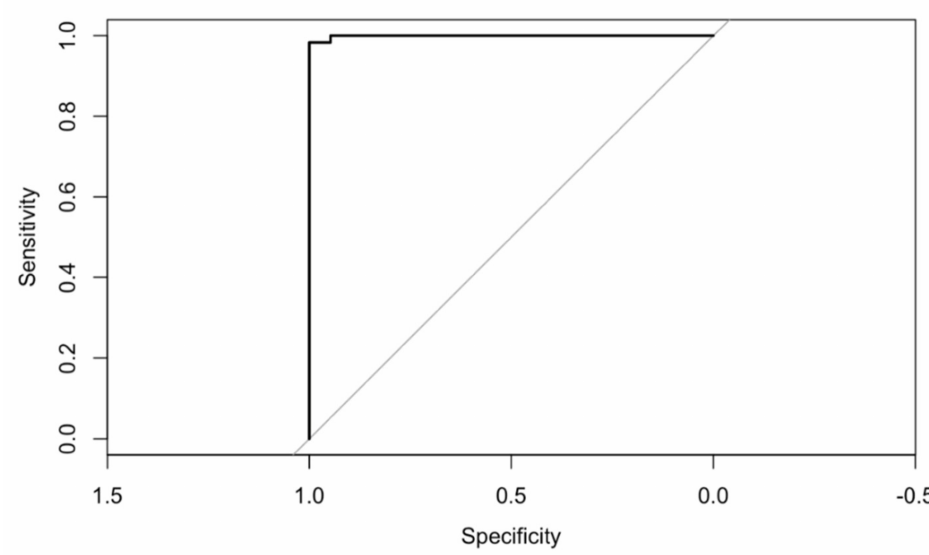
Figure 5. ROC curve. Random Forest